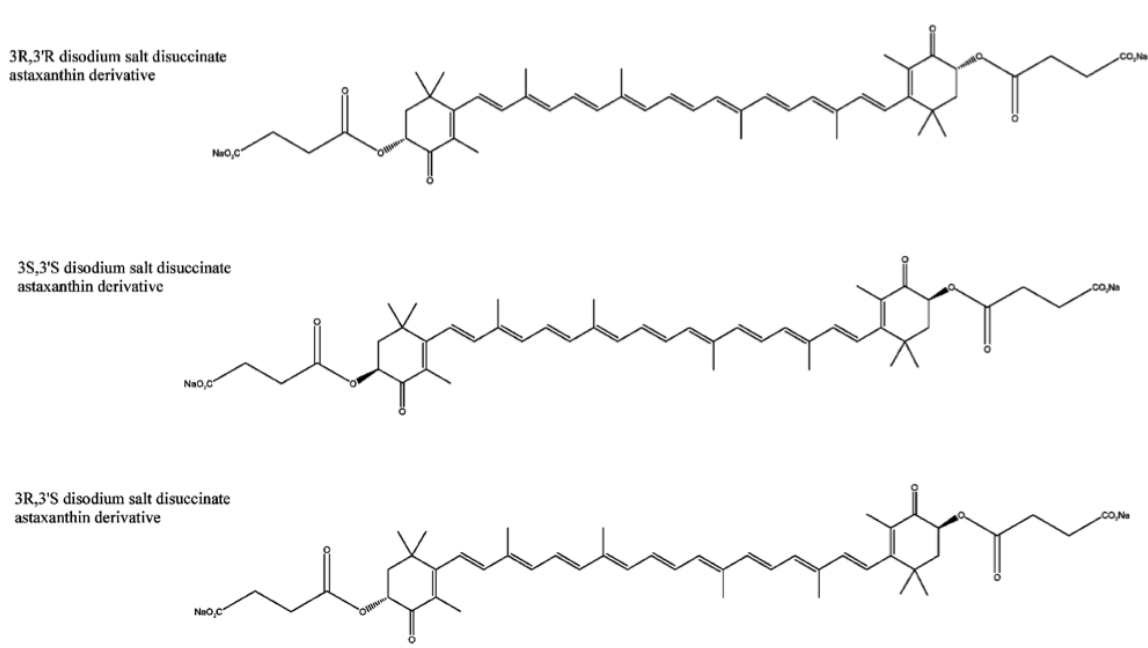
Figure 2. Three stereoisomers of the derivative DDA